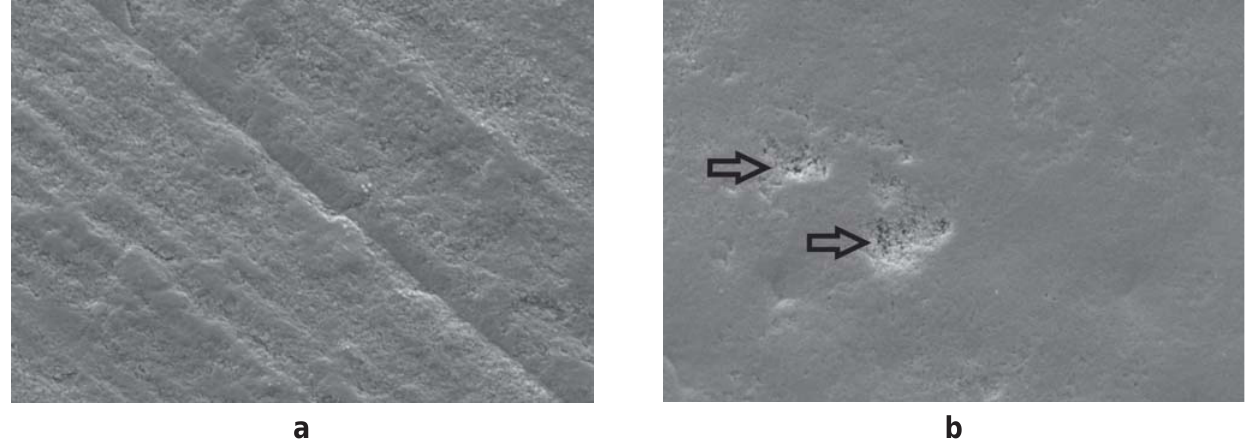
a b FIGURE 10- SEMs of ground (10a) and intact (10b) enamel surfaces treated with Unifil Bond self-etching primer. Mild etching effects were produced with shallow pits (arrows) in intact surfaces (10b) (x10,000)